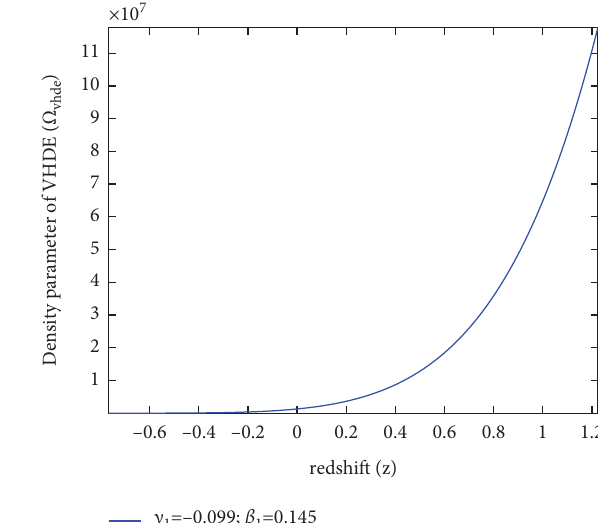
Figure 25: Density parameter of VHDE ( Ω for BT-II.